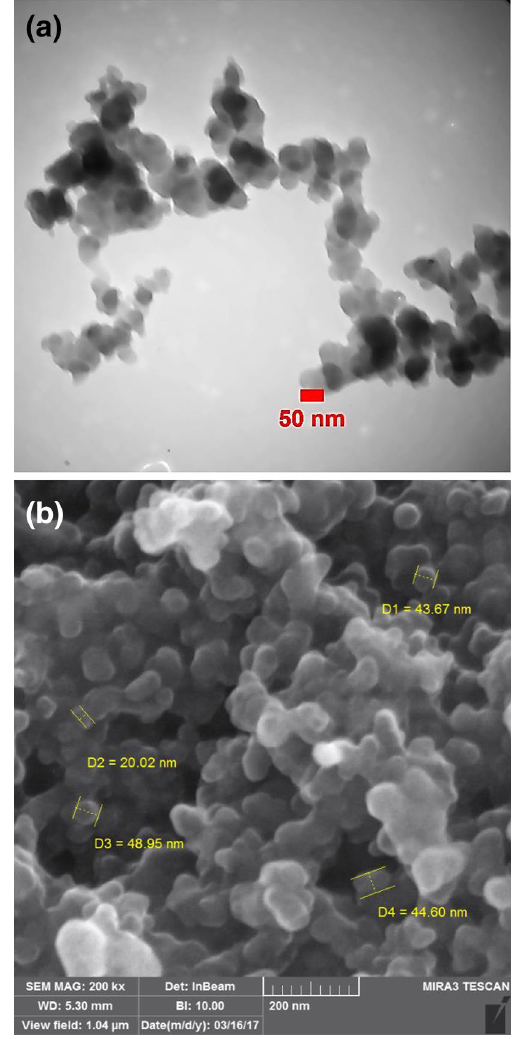
Fig. 1 a TEM image of GNPs, b SEM image of